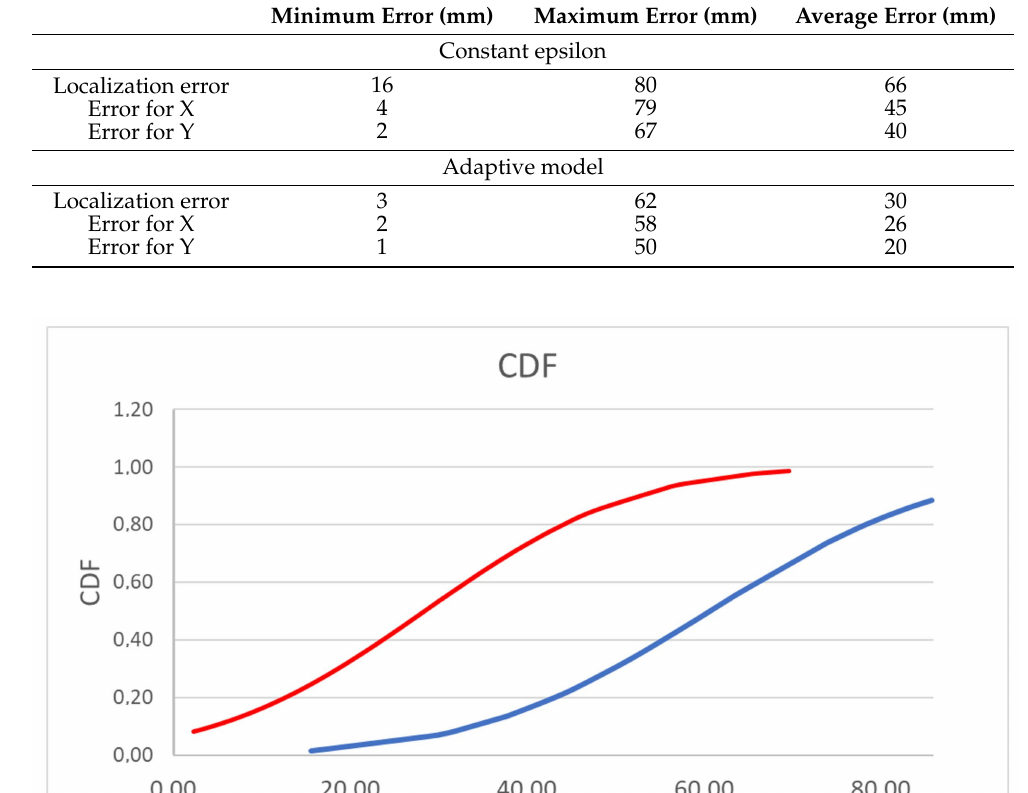
Table 2. Localization accuracy for different algorithms.